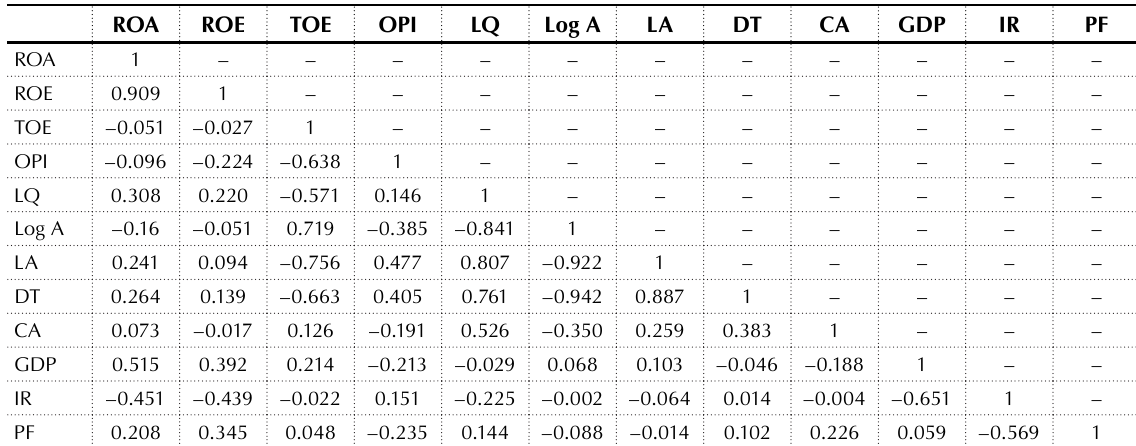
Table 3. Multicollinearity